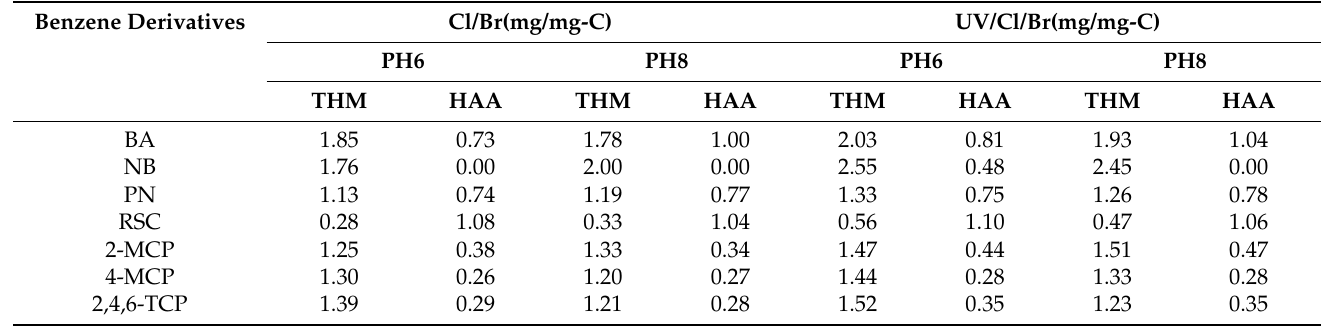
Table 4. Bromine incorporation factors of THMs and HAAs from the seven benzenes under the following conditions: Chlorine dose = 10 mg Cl 2 /L, pH = 6.0 or 8.0, [model benzene precursors] 0 = 3 mg-C/L, UV fluence rate = 10 mW/cm 2 , [Br − ] = 1